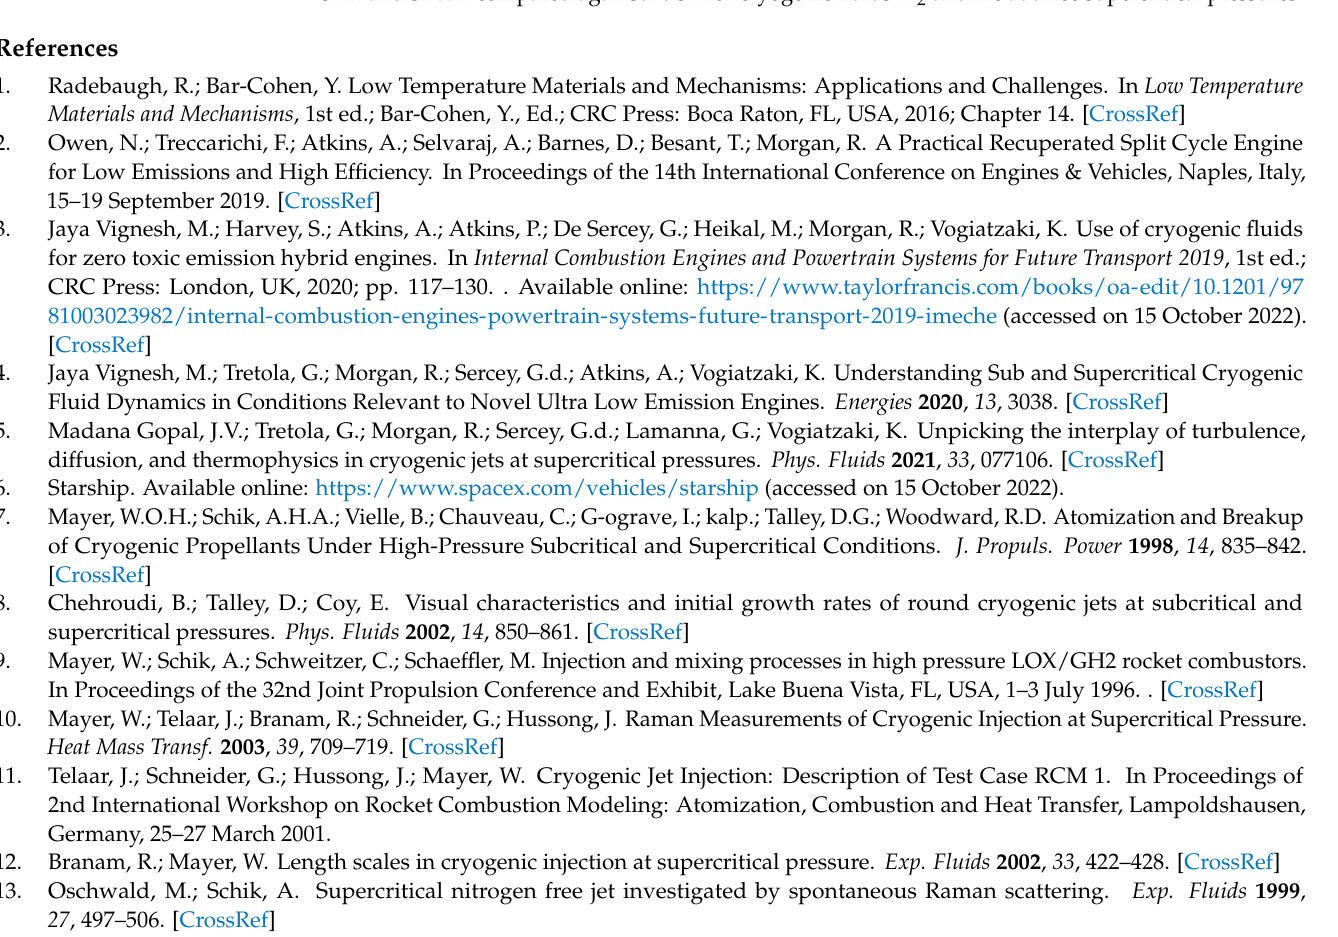
Figure A3. Plots of estimated thermal conductivity using Chung et al.’s model and density from PR, SRK and SBWR compared against NIST for cryogenic fluids-H 2 and He at three supercritical